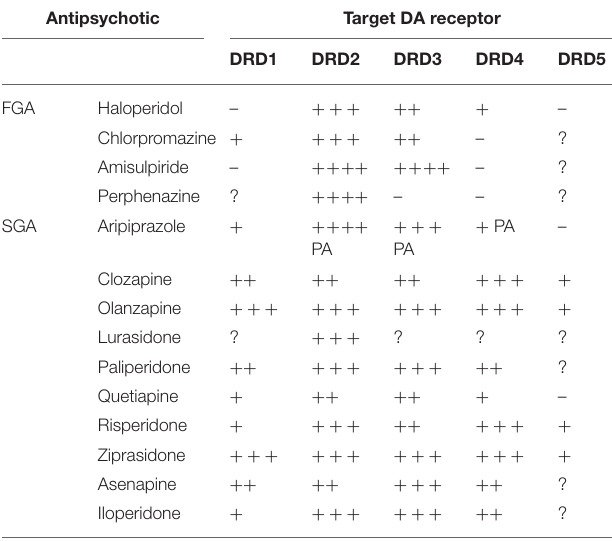
TABLE 1 | List of main First-Generation (FGA) and Second-Generation (SGA) Antipsychotics with respective target Dopamine (DA) Receptors